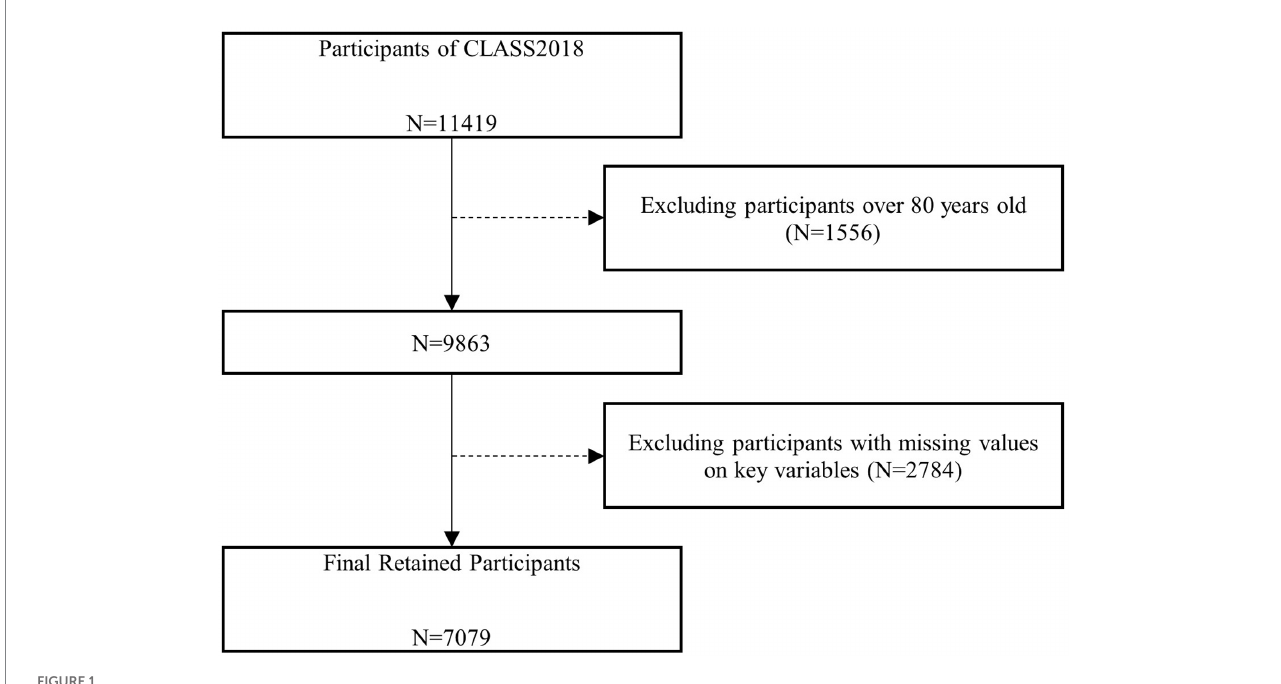
FIGURE 1 Data cleaning